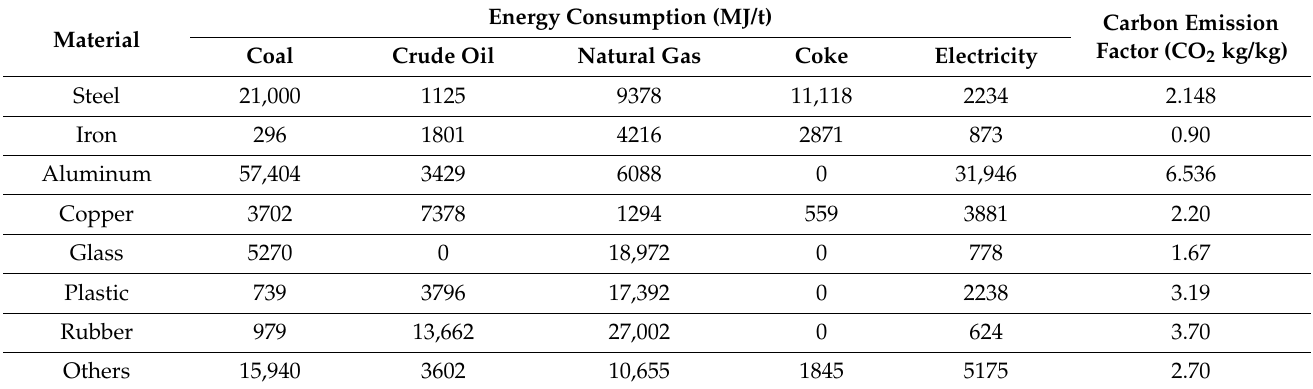
Table A2. Energy consumption and carbon emission factor of material production.